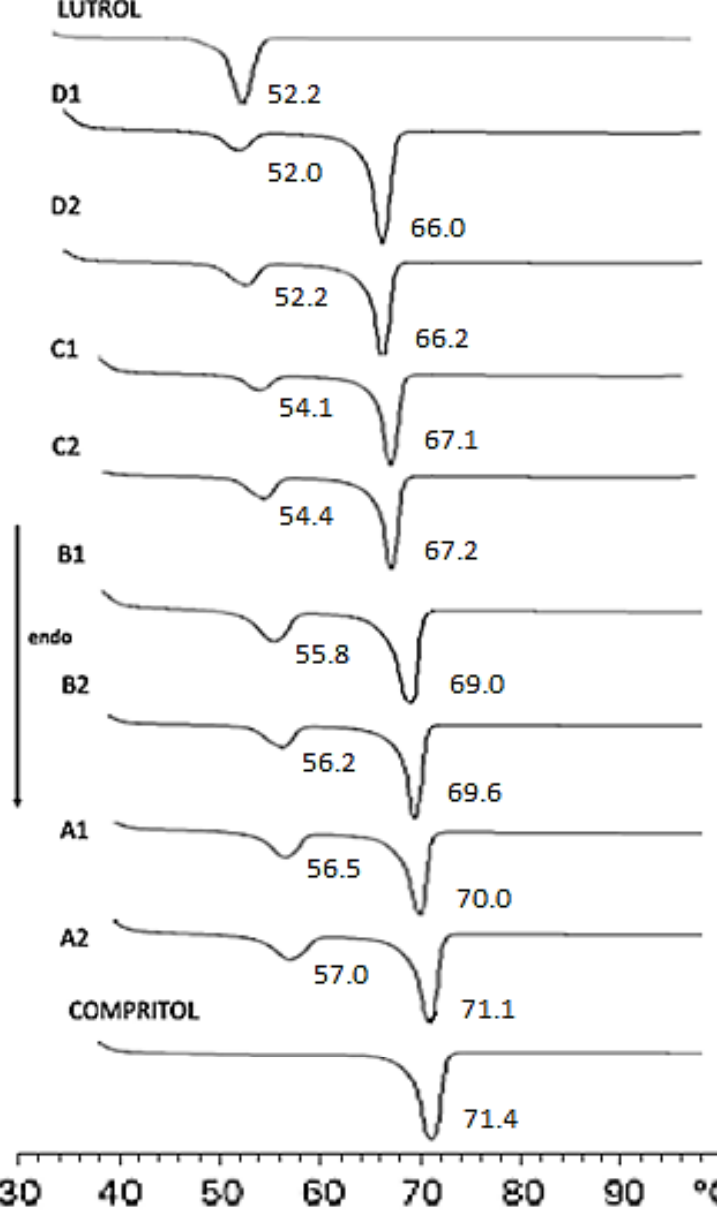
Figure 2. Differential scanning calorimetry of raw materials (Lutrol F68; Compritol 888 ATO) and processed batches (A 1 , A 2 , B 1 , B 2 , C 1 , C 2 , D 1 , and D 2 ) of SLNs. The number next to each peak represents the peak temperature (expressed as °C).